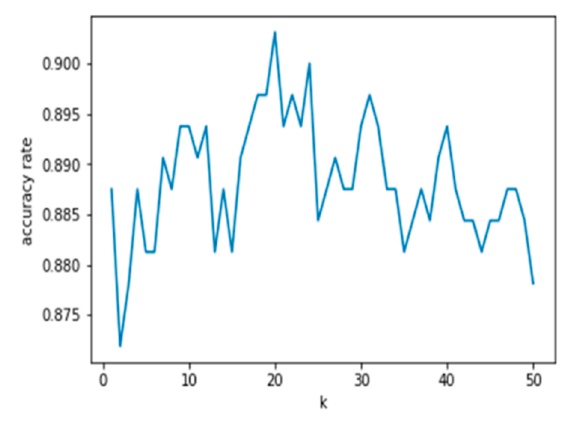
Figure 8. Diagnosis accuracy result of F1F2 in the case of k-NN.